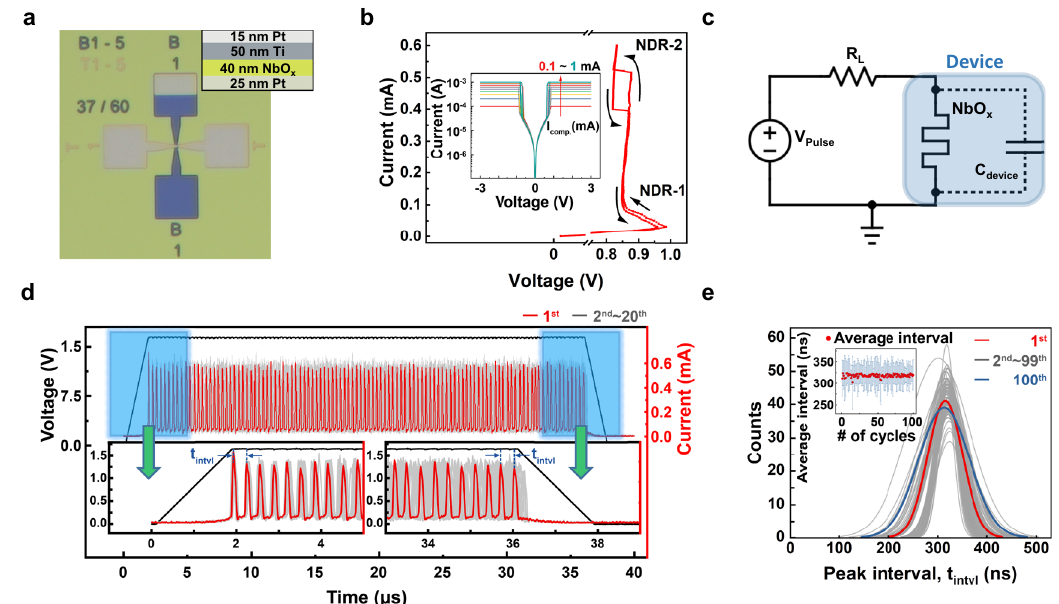
Fig. 1 Electrical properties of NbO x -based threshold switching (TS) device, and its stochastic oscillation. a An optical microscope image of the NbO x - based two terminal device. The inset shows the stack of the device. b A representative I – V curve with a current sweep mode showing two negative differential resistance (NDR) behaviors, noted to NDR-1 and NDR-2. The inset shows I – V curves in a voltage sweep mode with compliance currents ranging from 0.1 mA to 1 mA. c An oscillator circuit composed of the device and a series resistor. The TS device composed of a volatile memristor and an internal capacitor. d Experimentally obtained 20 oscillation current outputs (red and gray) under a fi xed input voltage pulse (black). The left and right insets magnify the initial and fi nal oscillation outputs, respectively. e A distribution of peak intervals ( t intvl ) at each oscillation output. It shows 100 distributions collected from 100 testing cycles. Inset shows the average and standard deviation of the t intvl for 100 testing de fi cient part (i.e., the anode interface) was crystallized to an insulating NbO 2 as the NbO 2 phase is thermodynamically stable.